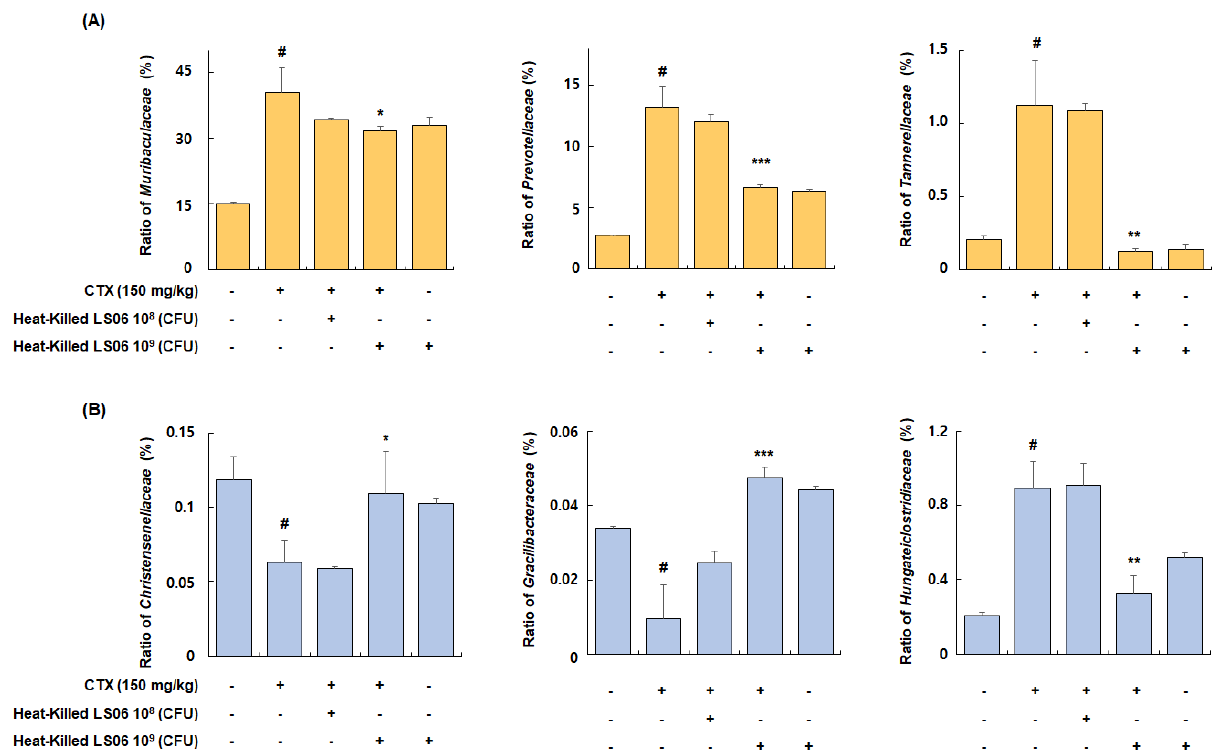
Figure 9. Effects of heat-killed LS06 treatment on family’s composition in CTX-treated mice. Relative abundance ratio of families of ( A ) Bacteroidetes and ( B ) Firmicutes. Data are presented as mean ± SEM ( n = 10). # p < 0.05 vs. Con group; * p < 0.05, ** p < 0.01, and *** p < 0.001 vs. CTX group.